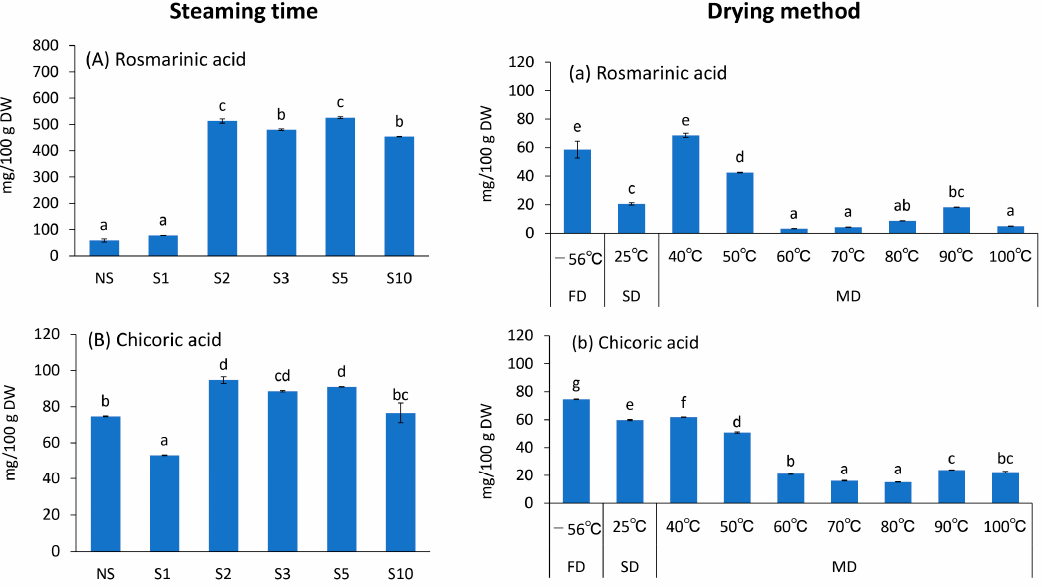
Figure 6. E ff ects of di ff erent treatment conditions on (A, a ) rosmarinic and ( B, b ) chicoric acid contents of Ocimum basilicum cv. ‘Genovese’ tea. FD: Freeze-drying (–56 °C, 48 h), NS: Non-Steaming, S1: Steaming for 1 min, S2: Steaming for 2 min, S3: Steaming for 3 min, S5: Steaming for 5 min, S10: Steaming for 10 min, SD: Shade-drying (25 °C, 7 days), MD 40 °C: Machine-drying at 40 °C, MD 50 °C: Machine-drying at 50 °C, MD 60 °C: Machine-drying at 60 °C, MD 70 °C: Machine-drying at 70 °C, MD 80 °C: Machine-drying at 80 °C, MD 90 °C: Machine-drying at 90 °C, and MD 100 °C: Machine-drying at 100 °C. The values are expressed as the standard reagents equivalent per dry weight. The results were obtained using Tukey’s test for multiple comparisons. Di ff erent le tt ers indicate signi fi cant di ff erences at p < 0.05. Data are expressed as mean ± SE (n = 4).